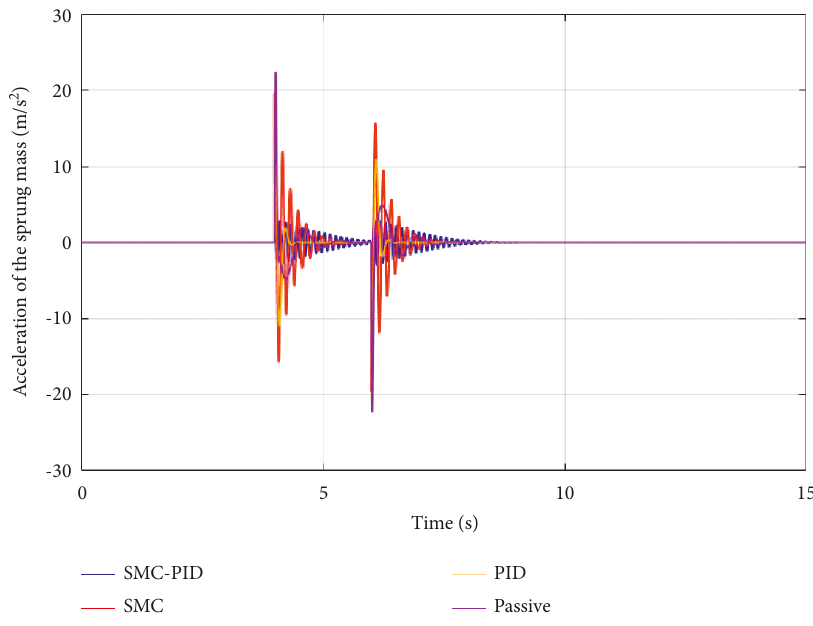
Figure 13: Acceleration of the sprung mass (Case